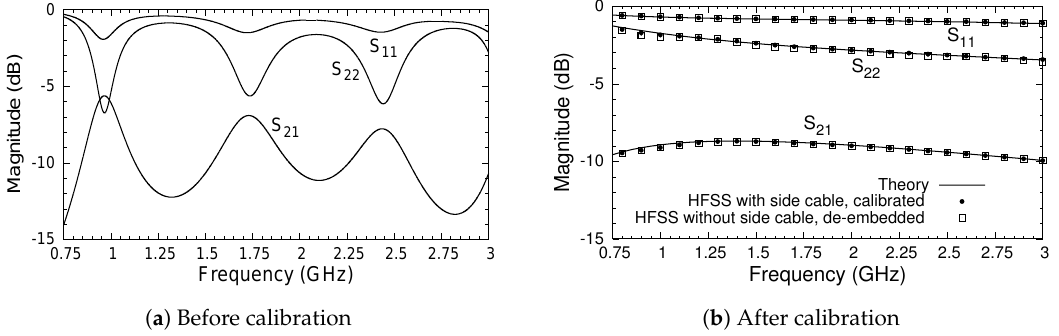
Figure 5. Magnitudes of the S-parameters of the triaxial system before and after calibration. Material sample is representative magnetic radar absorbing material MagRAM.